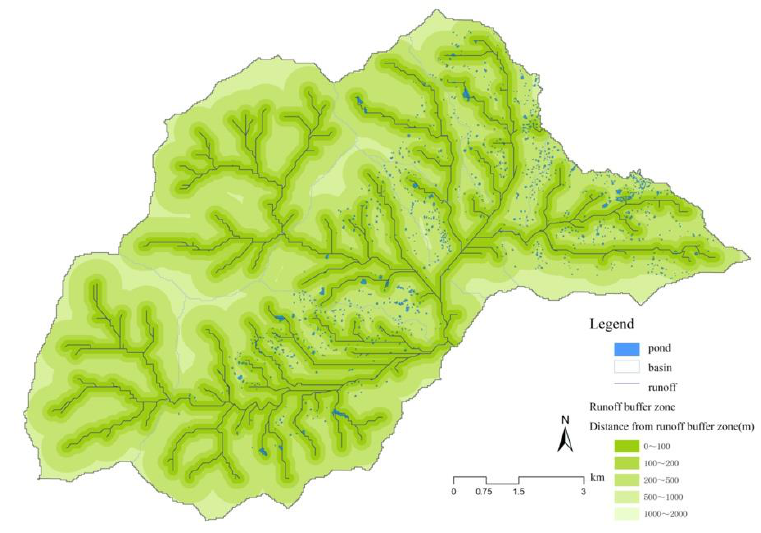
Figure 12. The runoff result for the Beitang landscape. Compared with actual rivers, simulated runoff can reflect potential surface runoff, the distribution of terminal without channelization, and water catchment trends, which are also useful for